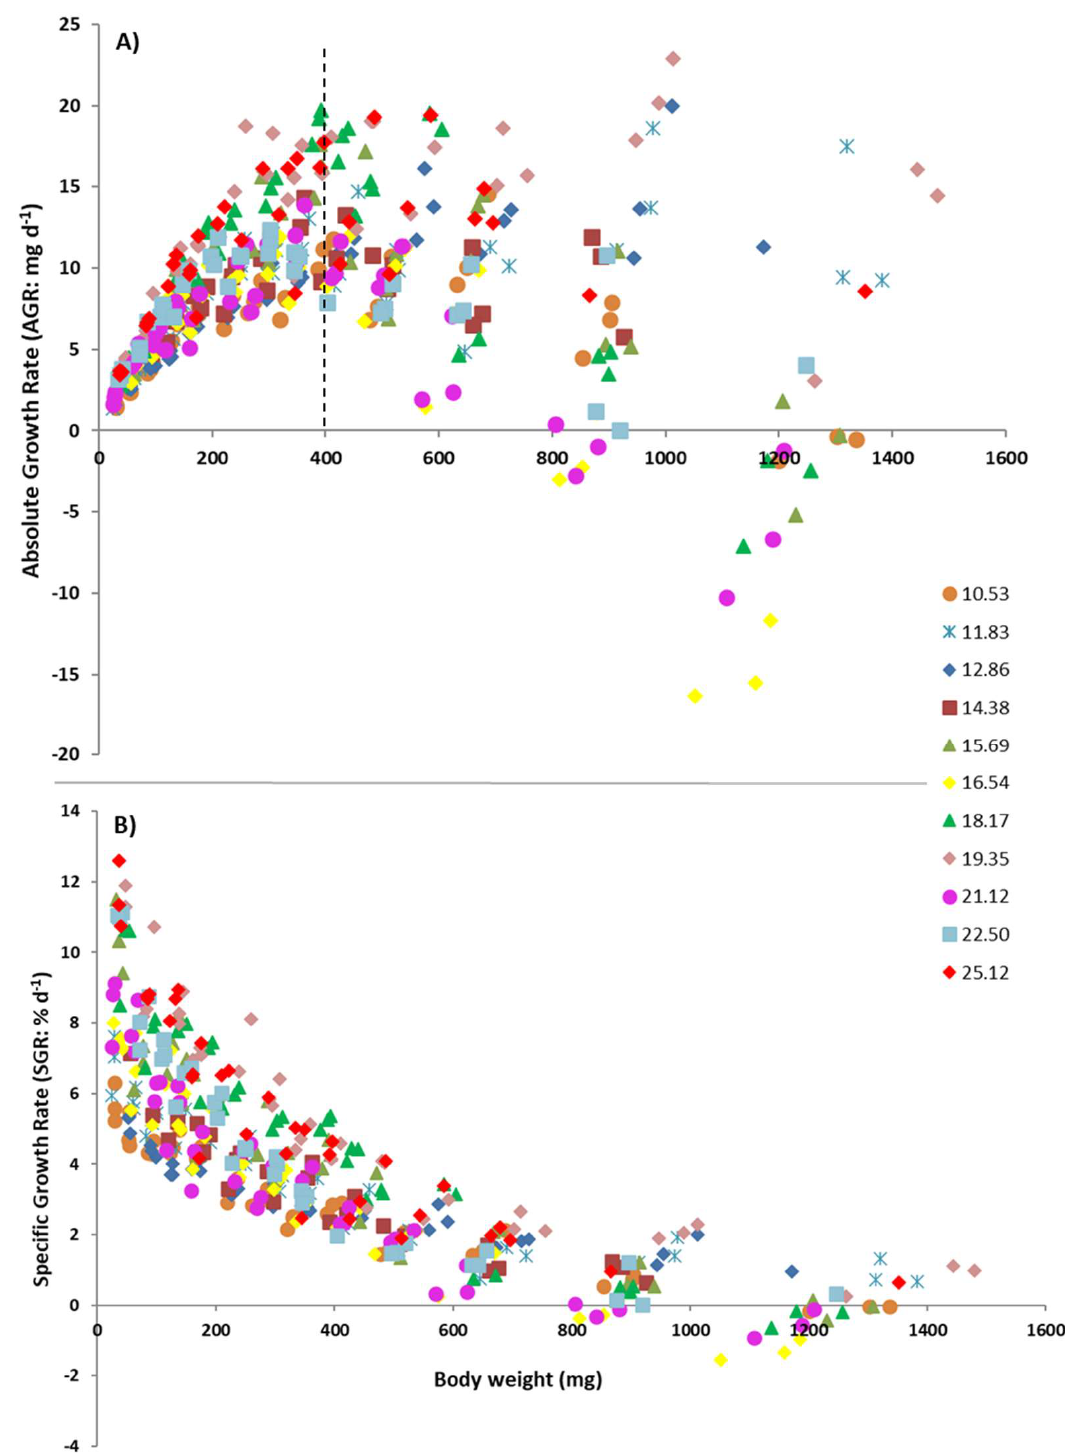
Figure 2. Plots of all ( A ) AGR and ( B ) SGR observed data for Bw and T tested in the growth assays. Vertical dotted line in A indicates the Bw value above which dispersion of AGR values is apparent. Table 1. Results of Pearson partial correlation test of body weight (Bw) and temperature (T) for mortality (M), absolute growth rate (AGR) and specific growth rate (SGR).